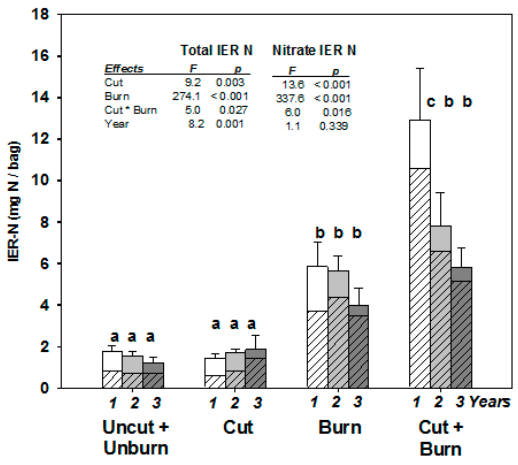
Figure 5. Plant-available soil N in bark beetle-infested, cut and burned forest conditions at the Church’s Park Fire, Colorado. Bars are the average total IER-N and nitrate IER-N (hatched) with standard error bars. The three years denote the 2011/2012, 2012/2013 and 2013/2014 overwinter sampling periods. Different letters denote differences within years based on Tukey’s pairwise adjusted comparisons of log-transformed total IER-N data.